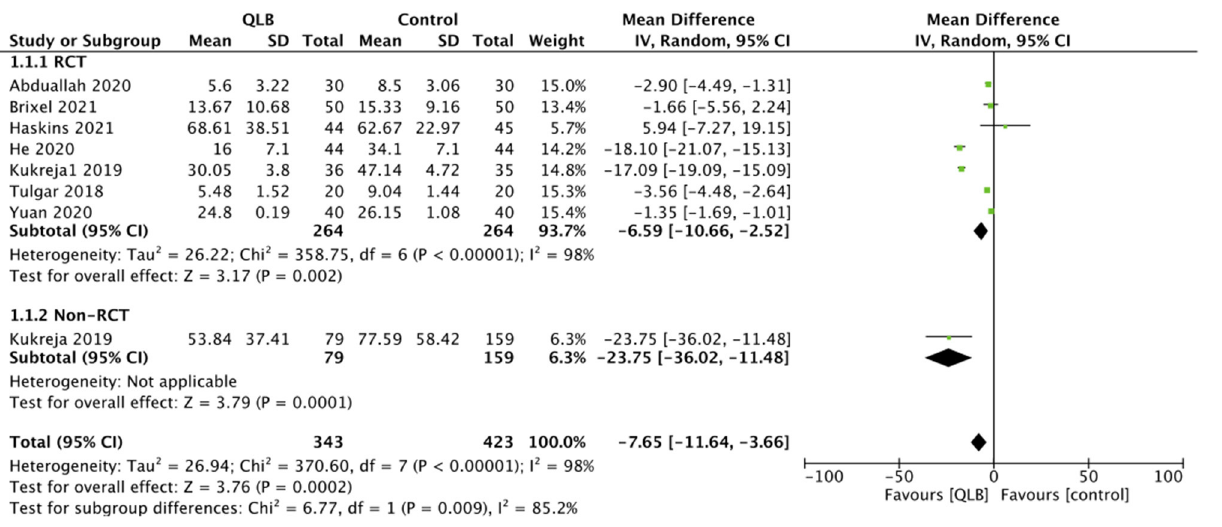
FIGURE 4 | Meta-analysis of 24-h total analgesic consumption between QLB and control groups with sub-group analysis based on study